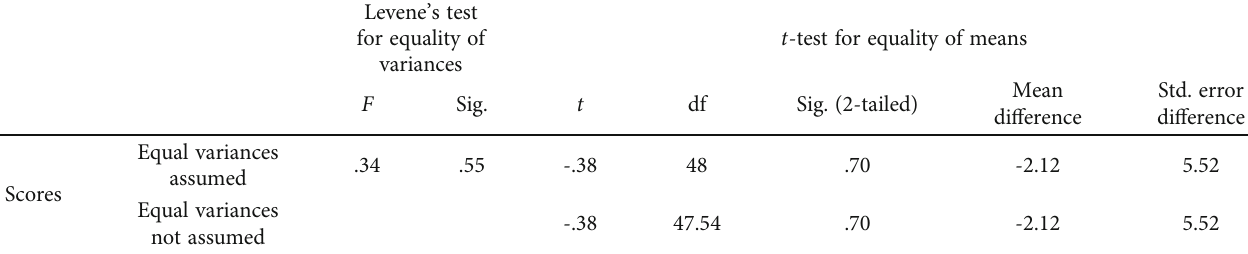
Table 7: Inferential statistics of the motivation pretests.